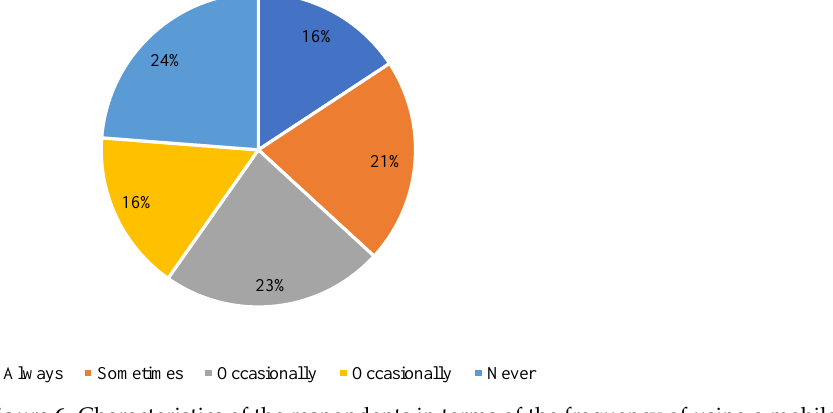
Figure 6. Characteristics of the respondents in terms of the frequency of using a mobile phone when crossing a pedestrian crossing.